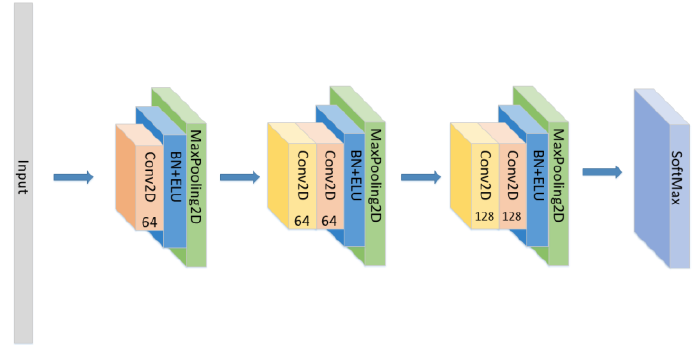
Figure 5. The construction of the CNN model.